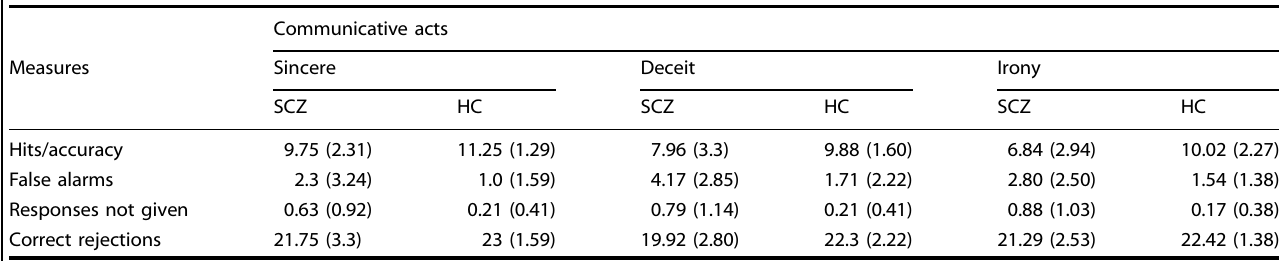
Table 3. Descriptive statistics of participants ’ performance in the pragmatic